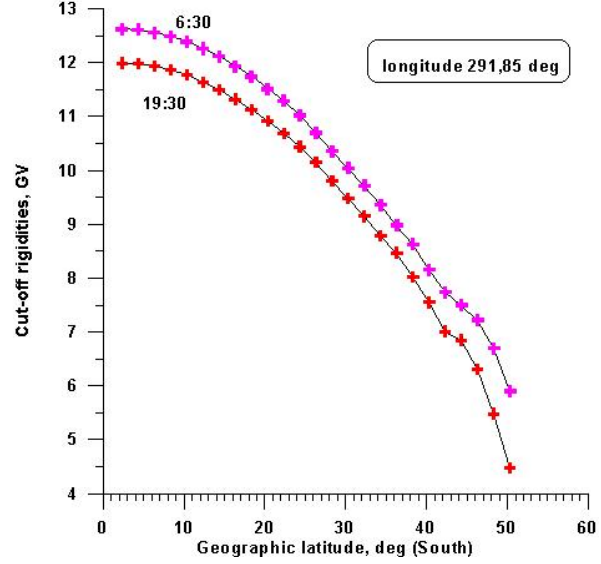
Fig. 6. The same as in Fig. 4 but for the Chacaltaya Figure 6. The same as in Figure 4 but for the Chacaltaya station.